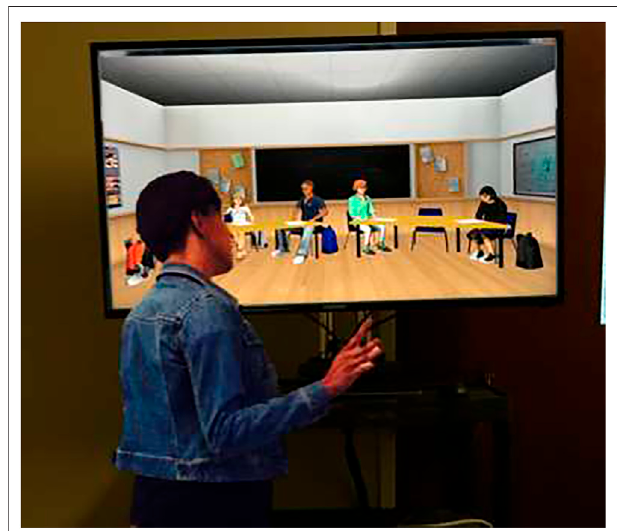
FIGURE 1 | The teacher practices teaching human in the loop virtual students in the mixed reality classroom simulation training system. Teacher is observed by virtual students through a web camera and voice over internet protocol